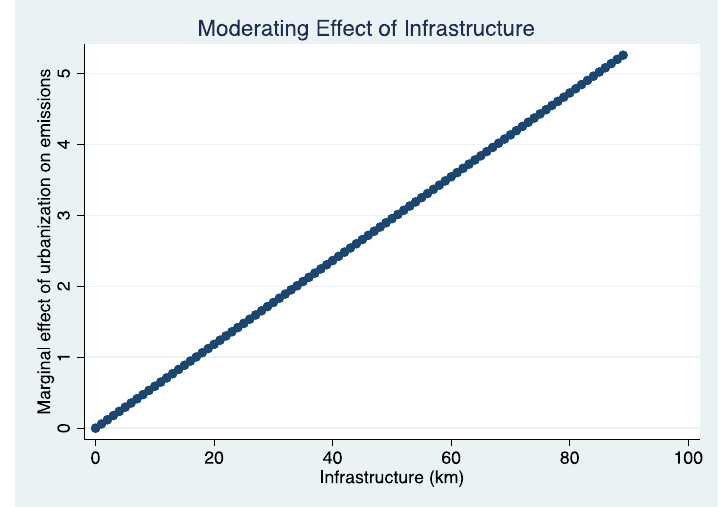
Figure 10. Moderating effect of infrastructure.